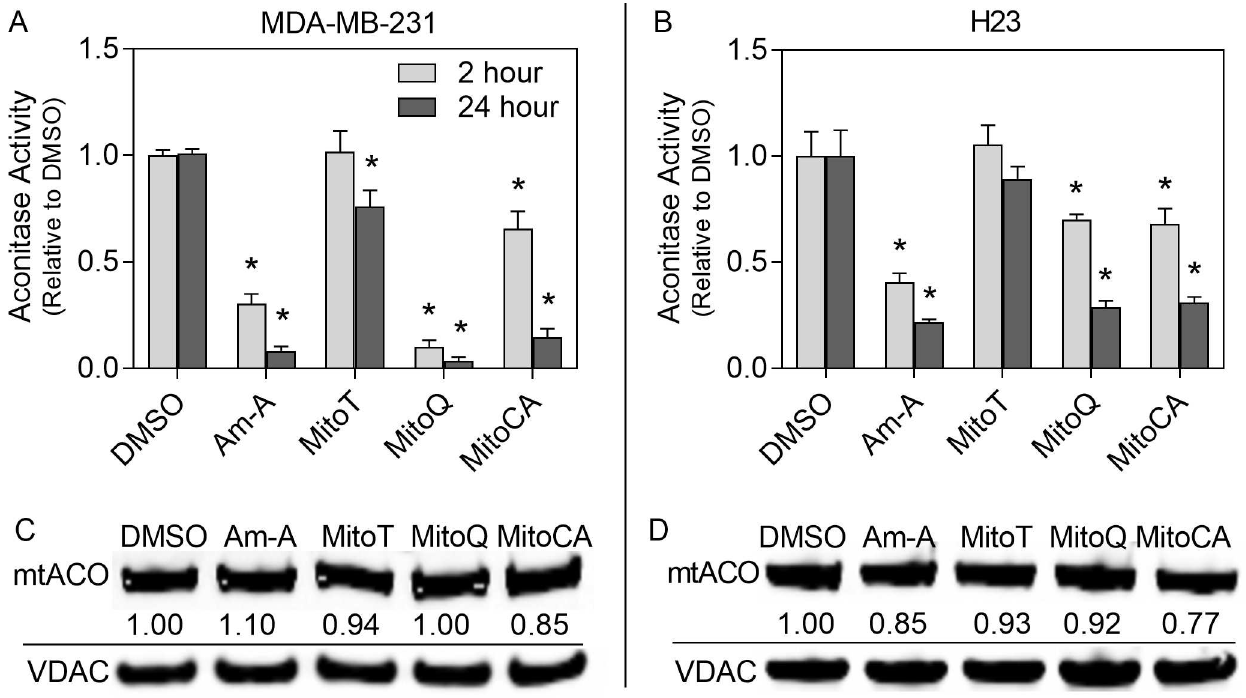
Fig 5. Mitochondrial TCA cycle aconitase activity. Aconitaseactivity was determinedwith the colorimetric aconitaseenzyme activity assay in MDA-MB-231 (A) and H23 (B) cell lines exposedto either DMSO (0.02%), MitoT, MitoQ or MitoCA at 2 μ M or Antimycin A (Am-A) at 40 μ M for 2 (light) or 24 (dark) hours. Bars represent the relative mitochondrial aconitaseactivity normalized to mitochondrial protein and the DMSO control +/-1 SEM. Statistical significance is representedby asterisks with a p < 0.05relative to the DMSO control. In C-D, immunoblots of mitochondrial extracts were probedwith anti-aconitase 2, and quantitated using densitometry and then normalized to VDAC and the DMSO treatment.